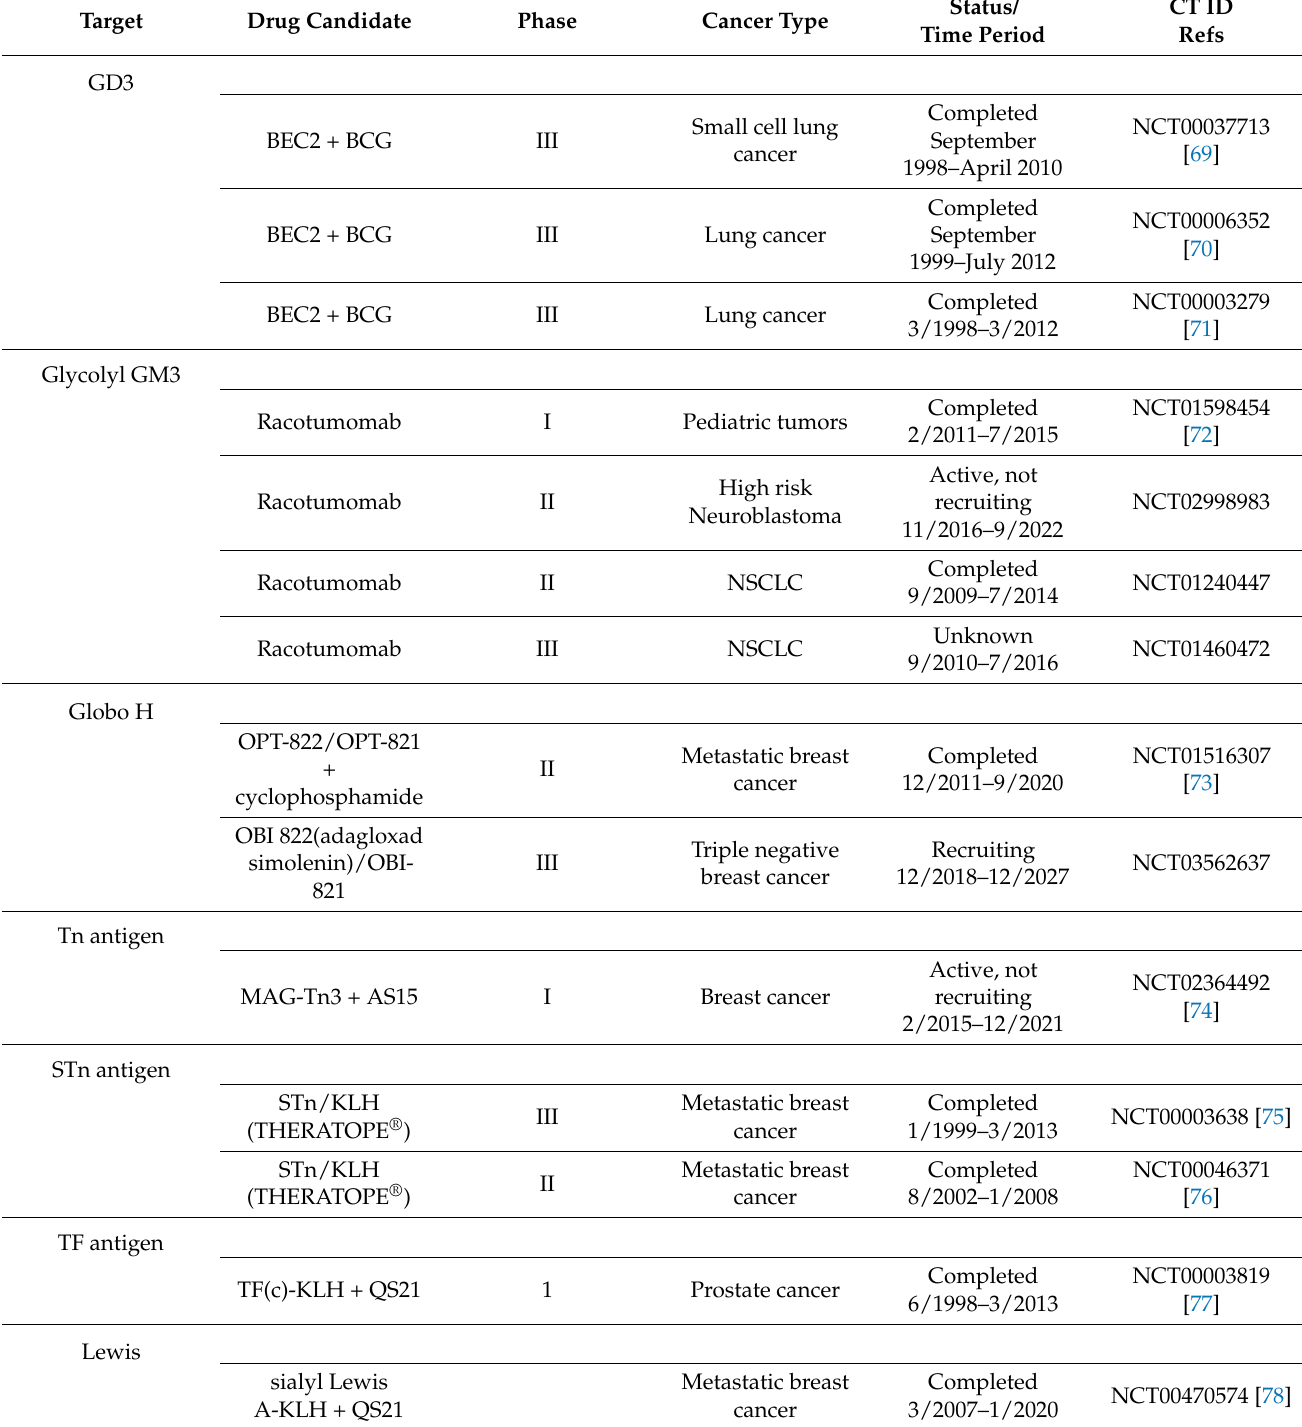
Table 3. Selected clinical trials of anti-cancer vaccines based on tumor